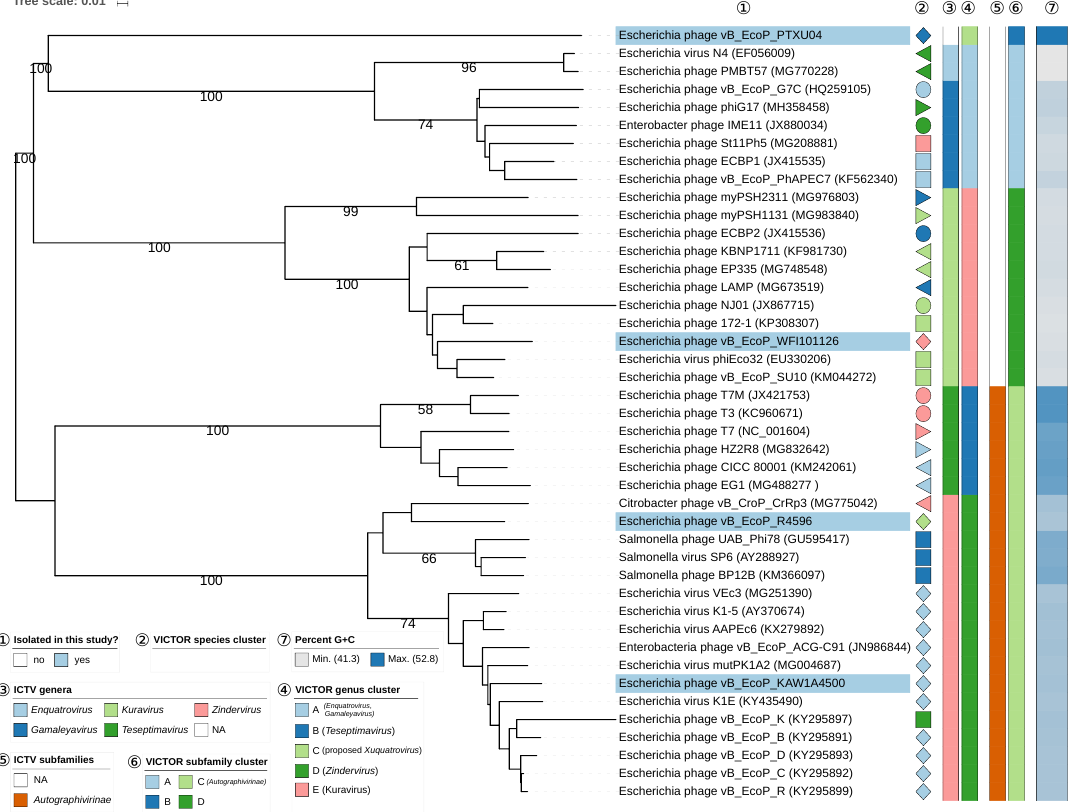
Figure 5. Phylogenomic analysis of Podoviridae members of this study at the amino acid level using VICTOR. The recommended VICTOR tree (formula d 6 ) is shown and the numbers shown above the branches are Genome-BLAST Distance Phylogeny (GBDP) pseudo-bootstrap support values from 100 replications, given that branch support exceeds 50%. The branch lengths of the resulting VICTOR trees are scaled in terms of the used distance formula. Annotations are given to the right-hand side of the tree: indicator for newly isolated phages (1), genera and subfamilies according to